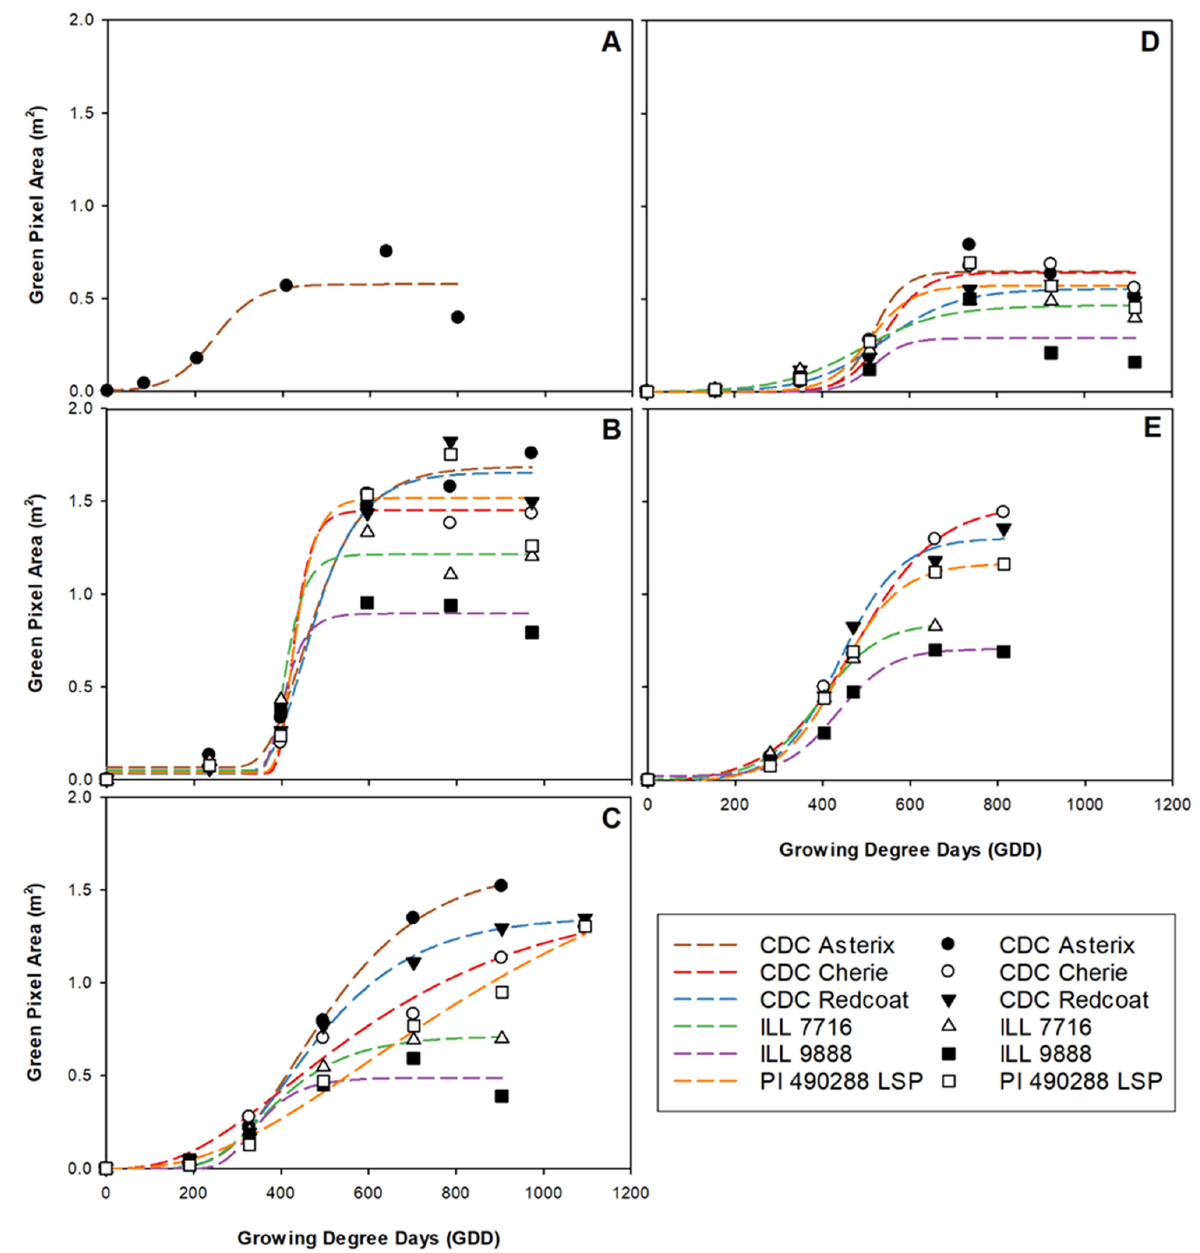
Figure 4. Three-parameter growth curves showing green pixel area accumulation for each genotype throughout the growing season at each site-year; Nasser 2017 ( A ), Rosthern 2017 ( B ), Sutherland 2017 ( C ), Nasser 2018 ( D ), and Rosthern 2018 ( E ). Data at Nasser 2017 was best described by combing all genotypes within the model.